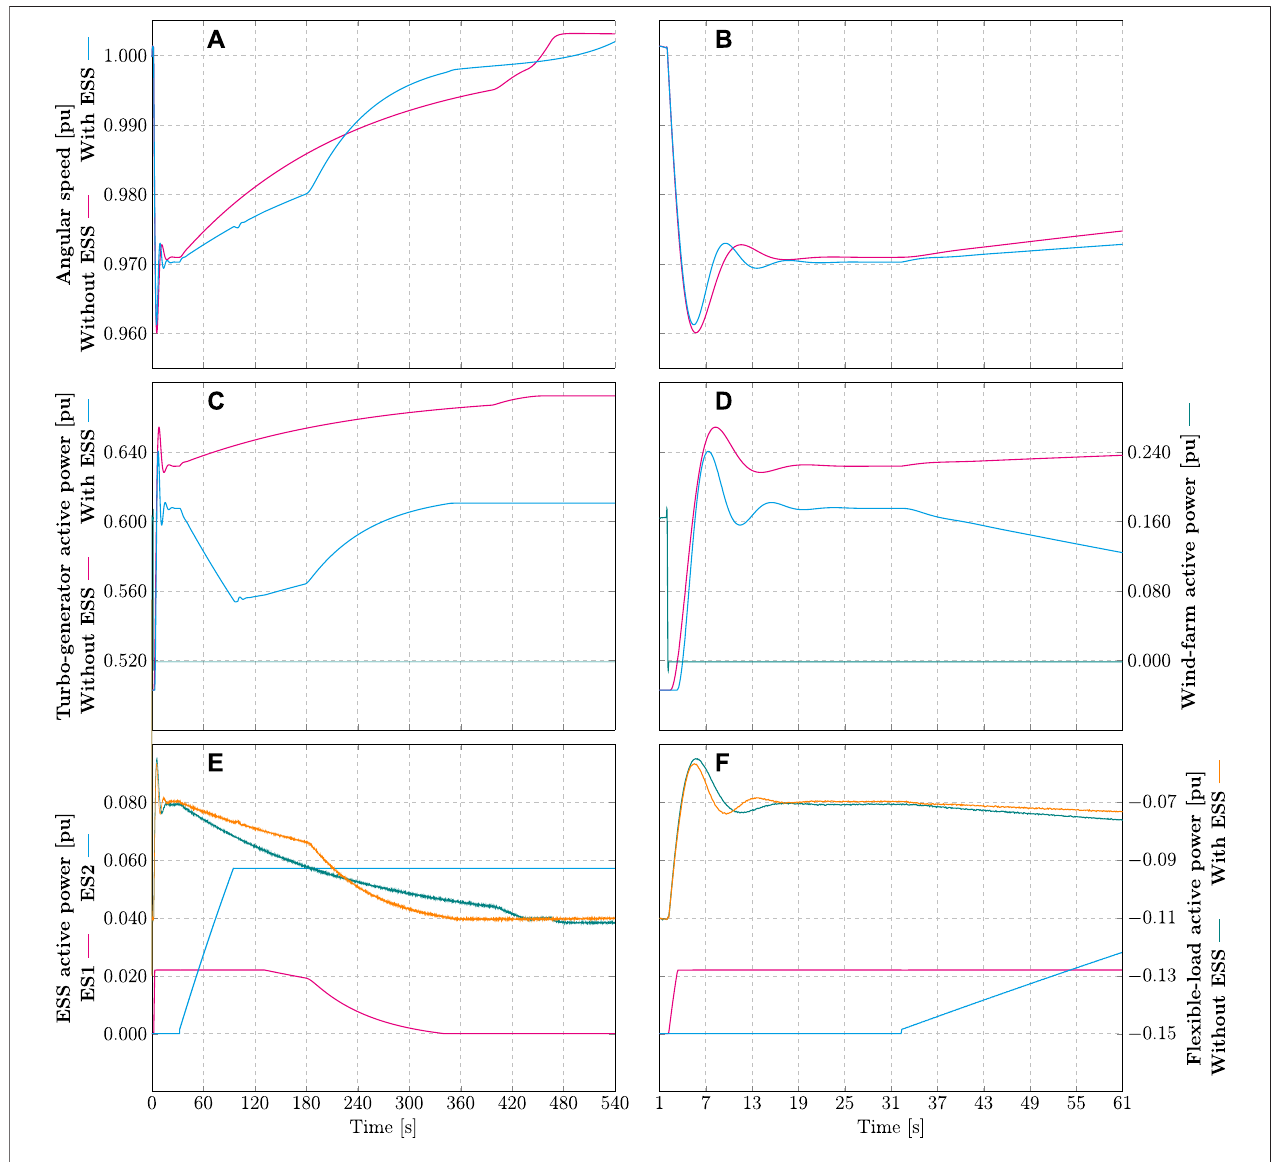
FIGURE 10 | Case study behavior during the wind farm disconnection under full production (12 MW) with and without the proposed ESS: normalized angular speed (A) duringthewholetransientand (B) detailofthe fi rstminute;turbo-generatorandwindfarmactivepowerinpu (C) duringthewholetransientand (D) detailofthe fi rst minute; active power of the ES devices responsible for primary control (ES1) and secondary control (ES2) (E) during the whole transient and (F) detail of the fi rst minute.